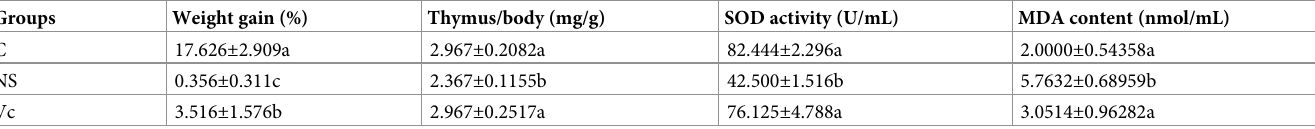
Table 2. Effects of whey protein intervention on physiological indexes of aging mice.